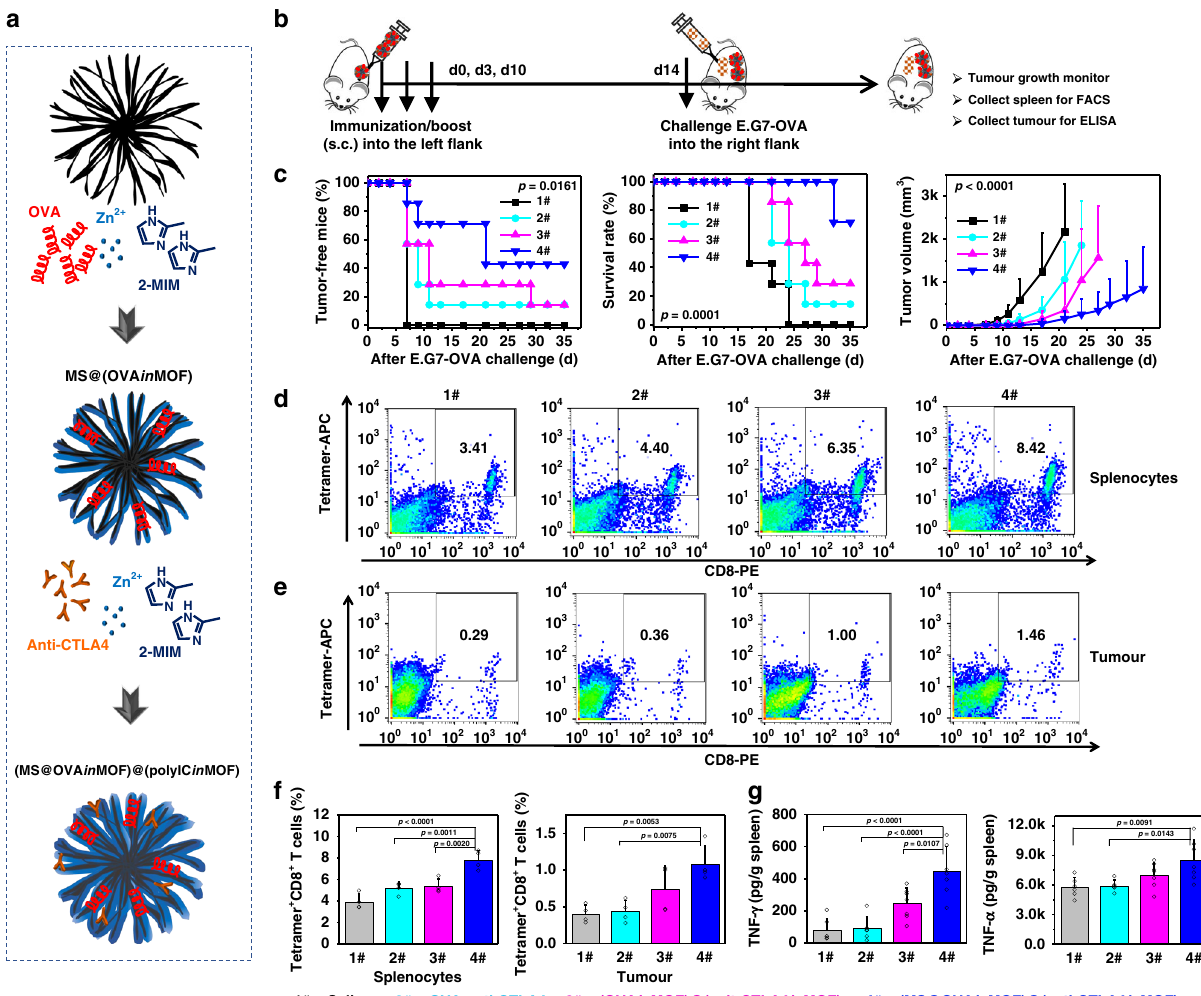
Fig. 4 Antitumour activity and tumour-speci fi c immune response in prophylactic mouse model. a Scheme of (MS@OVA in MOF)@(anti-CTLA4 in MOF) fabrication. b Timeline of experiment: female C57Bl/6J mice were immunised with subcutaneous injection of cancer vaccines into the left fl ank three times at 0, 3 and 10 days, challenged with 5×10 5 cells mouse − 1 of E.G7-OVA cells into the right fl ank at 14 day and monitored whether vaccines inhibited tumour growth or not. 1# Saline group; 2# free OVA-anti-CTLA4 group (OVA, 100 μ g/mouse; anti-CTLA4 Ab, 20 μ g/mouse); 3# (OVA in MOF)@(anit-CTLA4 in MOF) group (OVA, 100 μ g/mouse; anti-CTLA4 Ab, 20 μ g/mouse; MOF, 600 μ g/mouse); and 4# (MS@OVA in MOF)@(anti-CTLA4 in MOF) (OVA, 100 μ g/mouse; anti- CTLA4 Ab, 20 μ g/mouse; MS@MOF, 600 μ g/mouse). c (MS@OVA in MOF)@(anti-CTLA4 in MOF) prevents the tumour occurrence, prolongs the survival rate and suppresses the tumour growth. Kaplan – Meier curve of tumour-free mice (left) and mice survival (middle), and tumour volume curve (right) after subcutaneously challenging E.G7-OVA cells into the right fl ank of vaccinated mice ( n = 7 independent animals; left, middle, log-rank; right, two-way ANOVA). d – f Representative fl ow cytometry plots ( d , e ) and population ( f ) of Tetramer + CD8 + T cells in splenocytes and tumour sites at the endpoint ( n = 4 independent animals, one-way ANOVA followed by Tukey ’ s multiple comparisons post hoc test; splenocytes, p <0.0001; tumour, p = 0.0036). g IFN- γ and TNF- α contents in the spleen (1#, 2#, n = 6 independent animals; 3#, 4#, n = 7 independent animals; one-way ANOVA followed by Tukey ’ s multiple comparisons post hoc test; IFN- γ , p <0.0001; TNF- α , p = 0.0058). All data ( c , right panel; f, g ) are presented as mean +